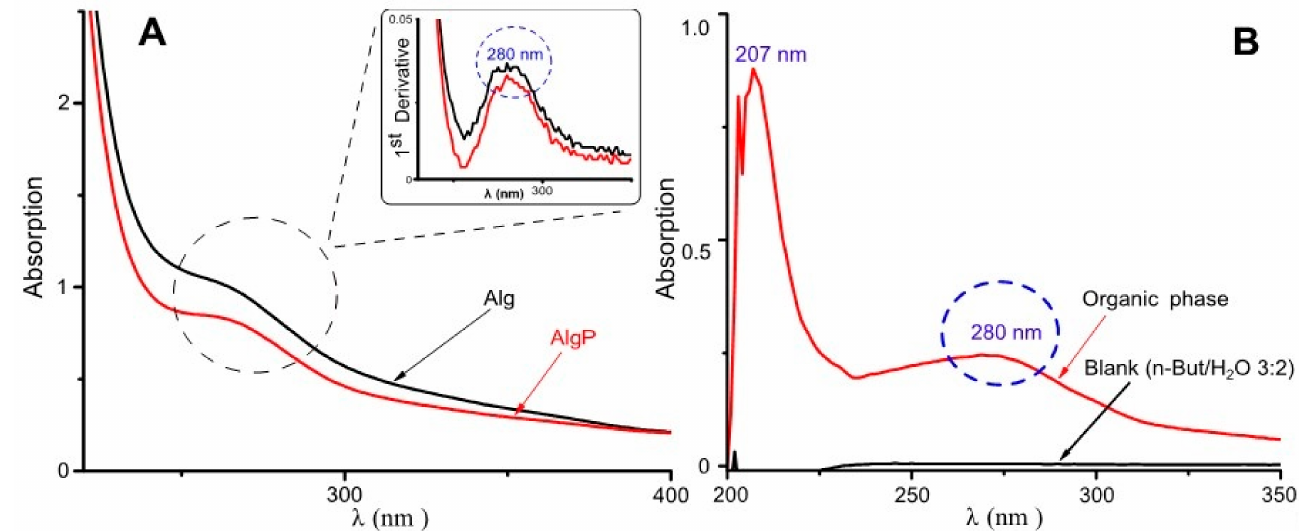
Figure 3. UV–Visible spectra for alginate purification. ( A ) Aqueous phase with the first derivative. ( B ) Organic phase.